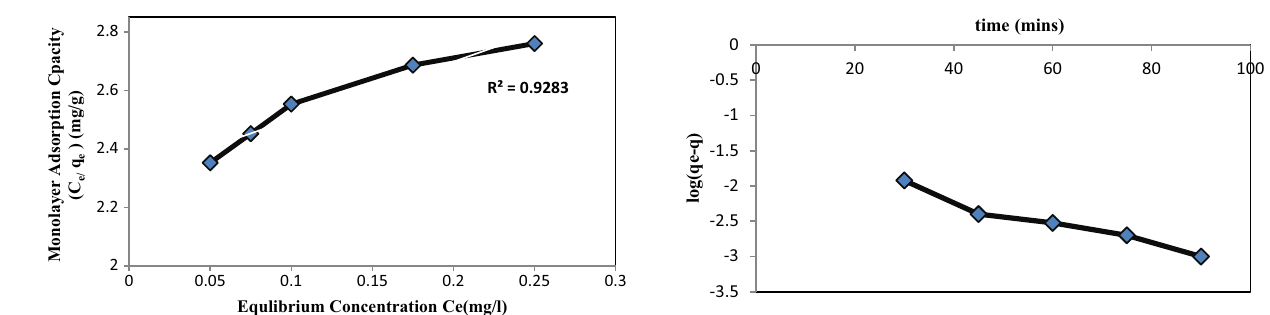
Fig. 5 Langmuir isotherm of HAp on arsenic of 0.3 mg/L at 120 rpm and temperature 30 °C and pH of 7